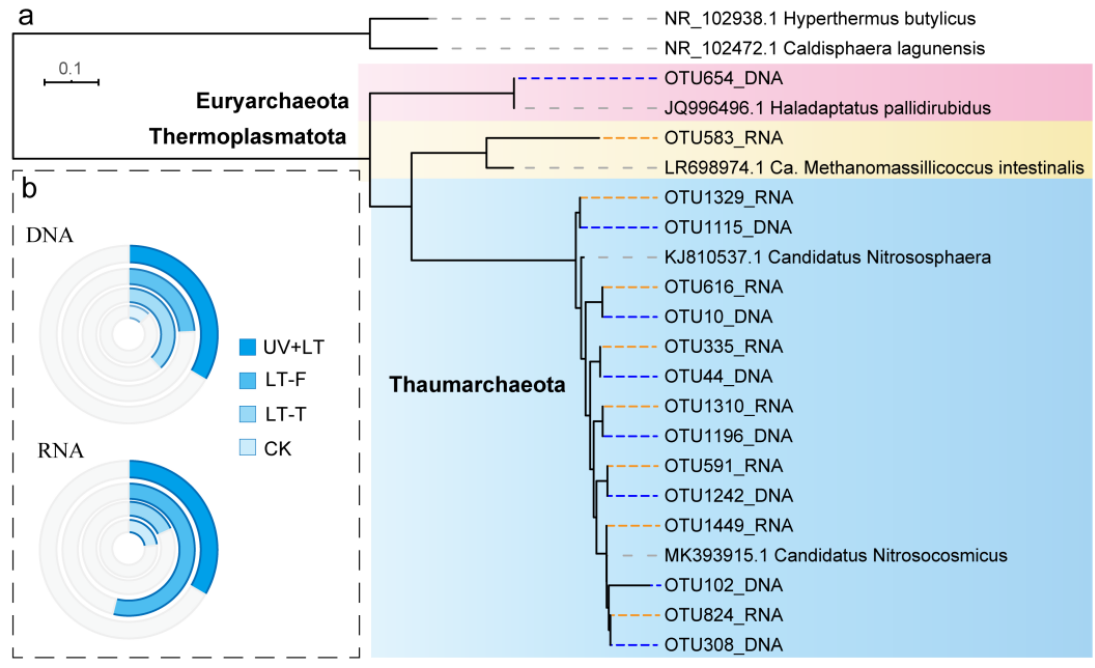
Figure 5. The neighbor-jointing tree ( a ) and relative abundance ( b ) of archaea. The blue and the gray in the circle represent Thaumarchaeota and other taxa, respectively. The larger the radian, the higher the relative abundance. The gray, bule and orange dot lines in the tree represent reference sequences, DNA sequences and RNA sequences, respectively. UV + LT: stratospheric exposure; LT-F: low-temperature freezing; LT-T: low-temperature thawing; CK: natural